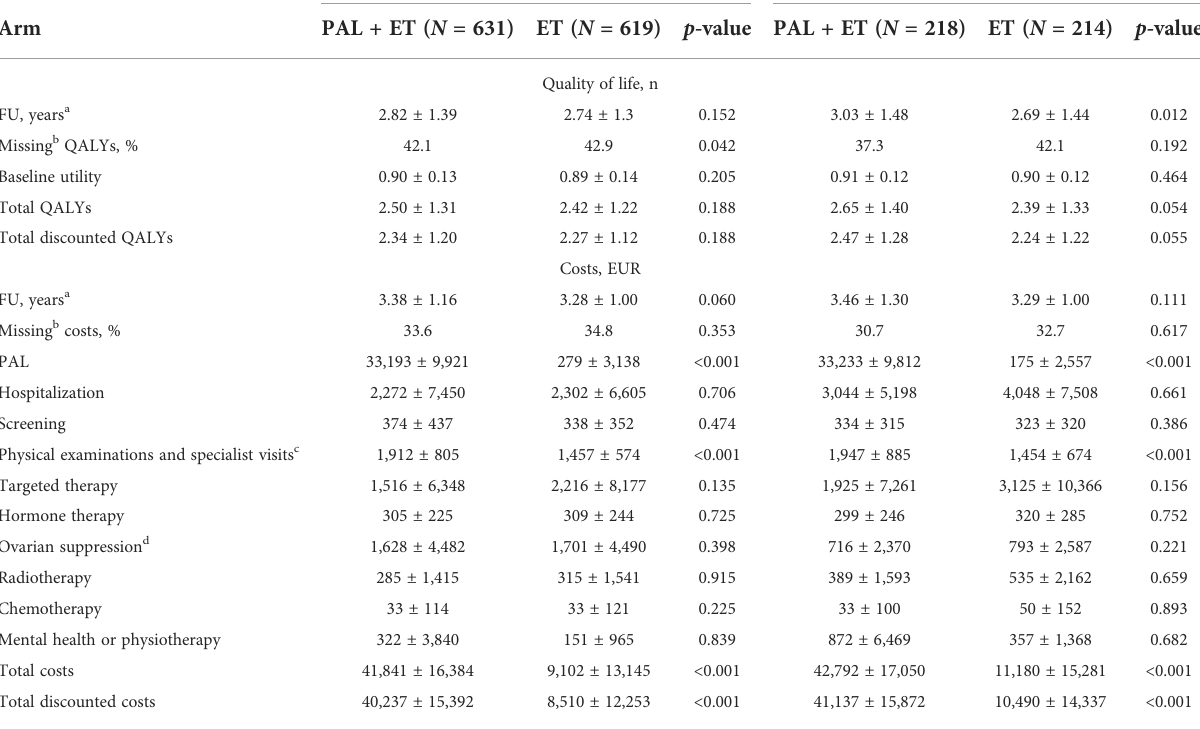
TABLE 2 Quality-adjusted life years and costs. Population All countries Germany